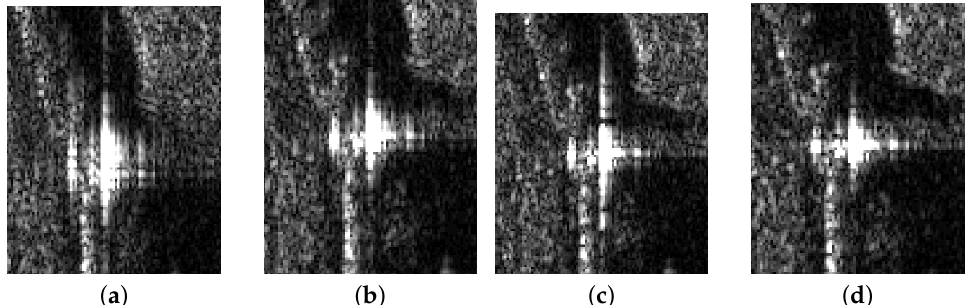
Figure 22. The comparison of 2D results of point targets. ( a ) The main POS imaging; ( b ) the left POS